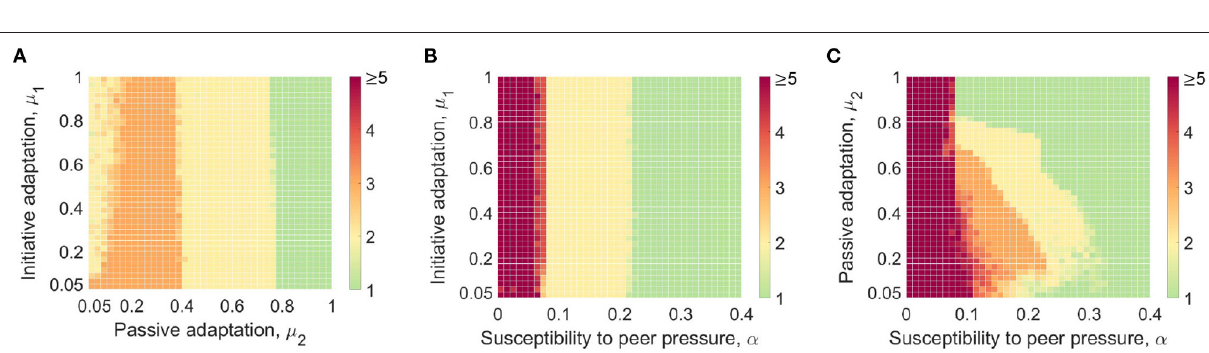
FIGURE 2 | Conjugate effect of confirmation bias and peer pressure. (A) Shown is the number of opinion clusters under different combinations of identity scope ( δ ) and susceptibility to peer pressure ( α ). (B,C) The number of opinion clusters is presented as a function of α and δ , respectively. We highlight the non-monotonous change in the number of opinion clusters with identity scope varying: the number first increases and then reduces to one with δ growing. (D–F) We present the distribution of final opinions under some situations. Parameters: µ 1 = 0.7, µ 2 = 0.7. In addition, (B) δ = 0.08, (C) α = 0.1, (D) δ = 0.08, α = 0, (E) δ = 0.08, α = 0.12, (F) δ = 0.08, α = 0.25.